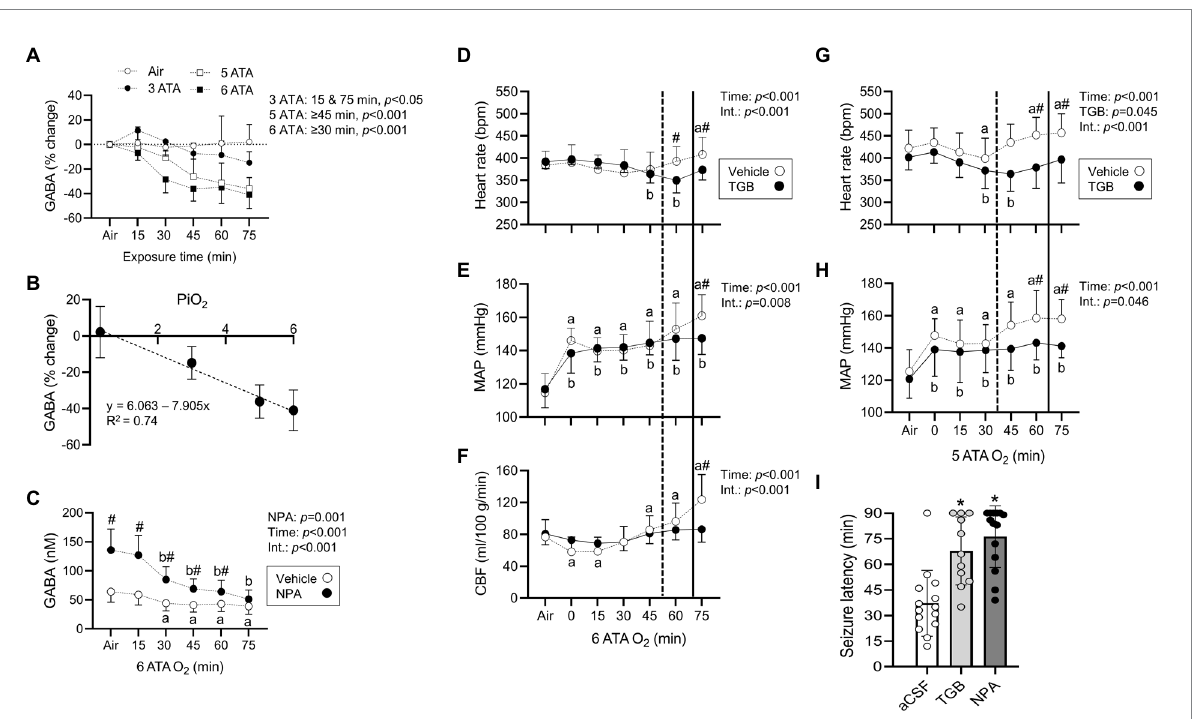
FIGURE 1 Striatal interstitial γ -aminobutyric acid (GABA) levels, cardiovascular and cerebral blood flow (CBF) responses in rats exposed to extreme HBO 2 . (A) Changes in the concentration of GABA measured before and every 15 min in air, 3, 5, and 6 atmospheres absolute (ATA) oxygen ( n = 7–8/group). (B) The relationship between changes in GABA levels (75 min to Air) and the inspired PO 2 (PiO 2 ). (C) Concentration of GABA measured before and every 15 min in HBO 2 at 6 ATA in rats perfused with aCSF (CON) or aCSF + NPA (70 μ M) into the caudate putamen ( n = 8/group). (D–F) Heart rate, mean arterial blood pressure (MAP), and CBF were measured in anesthetized rats before and during exposure to 6 ATA oxygen ( n = 8–10/group). (G,H) Heart rate and MAP were measured in conscious rats before and during exposure to 5 ATA oxygen ( n = 7–8/group). In both experiments, rats were injected with aCSF (CON) or aCSF + TGB in 5% DMSO (0.34 μ mol/7 μ l) into the lateral ventricle 30 min before HBO 2 . (D–H) Vertical dotted (aCSF) and bold (TGB) lines represent mean seizure latencies determined from EEG recordings. (I) Mean seizure latency in conscious rats injected with aCSF, aCSF + TGB in 5% DMSO (0.34 μ mol/7 μ l), or aCSF + NPA in 5% DMSO (1.1 μ mol/7 μ l) into the lateral ventricle 30 min before HBO 2 at 5 ATA ( n = 11–14/group). Values are means ± SD. Time dependent changes in a aCSF and b NPA or TGB groups, p < 0.05. # Between group differences, p < 0.05. *Significantly different from aCSF rats, p <